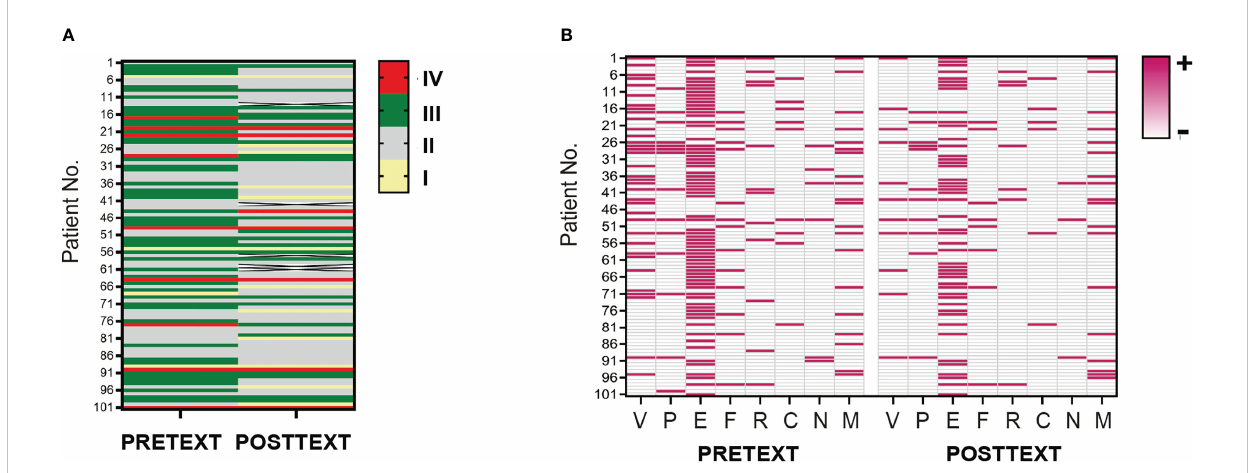
FIGURE 3 PRETEXT and POSTTEXT assessment in patient cohort of HB. (A) . Tumor extent before and after neoadjuvant chemotherapy in the full cohort of patients were evaluated by PRETEXT and POSTTEXT staging. Each row in the heatmap demonstrates one patient. Yellow, grey, green and red lines indicate stage I, II, III, IV. (B) . Distribution of radiological annotation factors in patient cohort before and after chemotherapy are shown. Pink and grey lines in the map indicate presence and absence of the annotation factors, respectively. PRETEXT, pretreatment extent of disease; POSTTEXT, posttreatment extent of